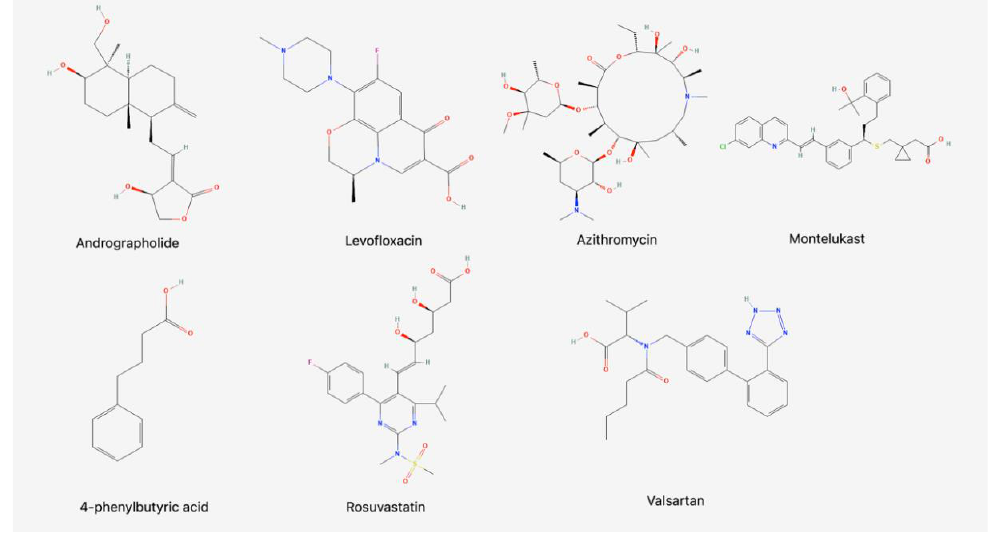
Figure 1. Two-dimensional structures of small molecules investigated in this work.